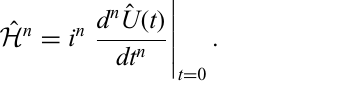
FIG. 1. Overview of the quantum power method proposed here. (a) The Hamiltonian power tion of the time-evolution operators [ ˆ U ((cid:3) τ / 2 ) ] n − 2 k for k = 0, 1, . . . , n , in which each ˆ U ((cid:3) τ / 2 ) is further decomposed into using the symmetric Suzuki-Trotter decomposition. Here, (cid:3) τ is a small time interval, and thus real positive number. E FD and E ST denote systematic errors due to the finite-difference scheme for the time derivatives and the symmetric Suzuki-Trotter decomposition of the time-evolution operators, respectively. (b) An illustration of the central-finite-difference scheme for the n th-order derivative of the time-evolution operator ˆ U ( t ) at t = 0. Pascal’s triangle with an alternating sign in time t and power n provides